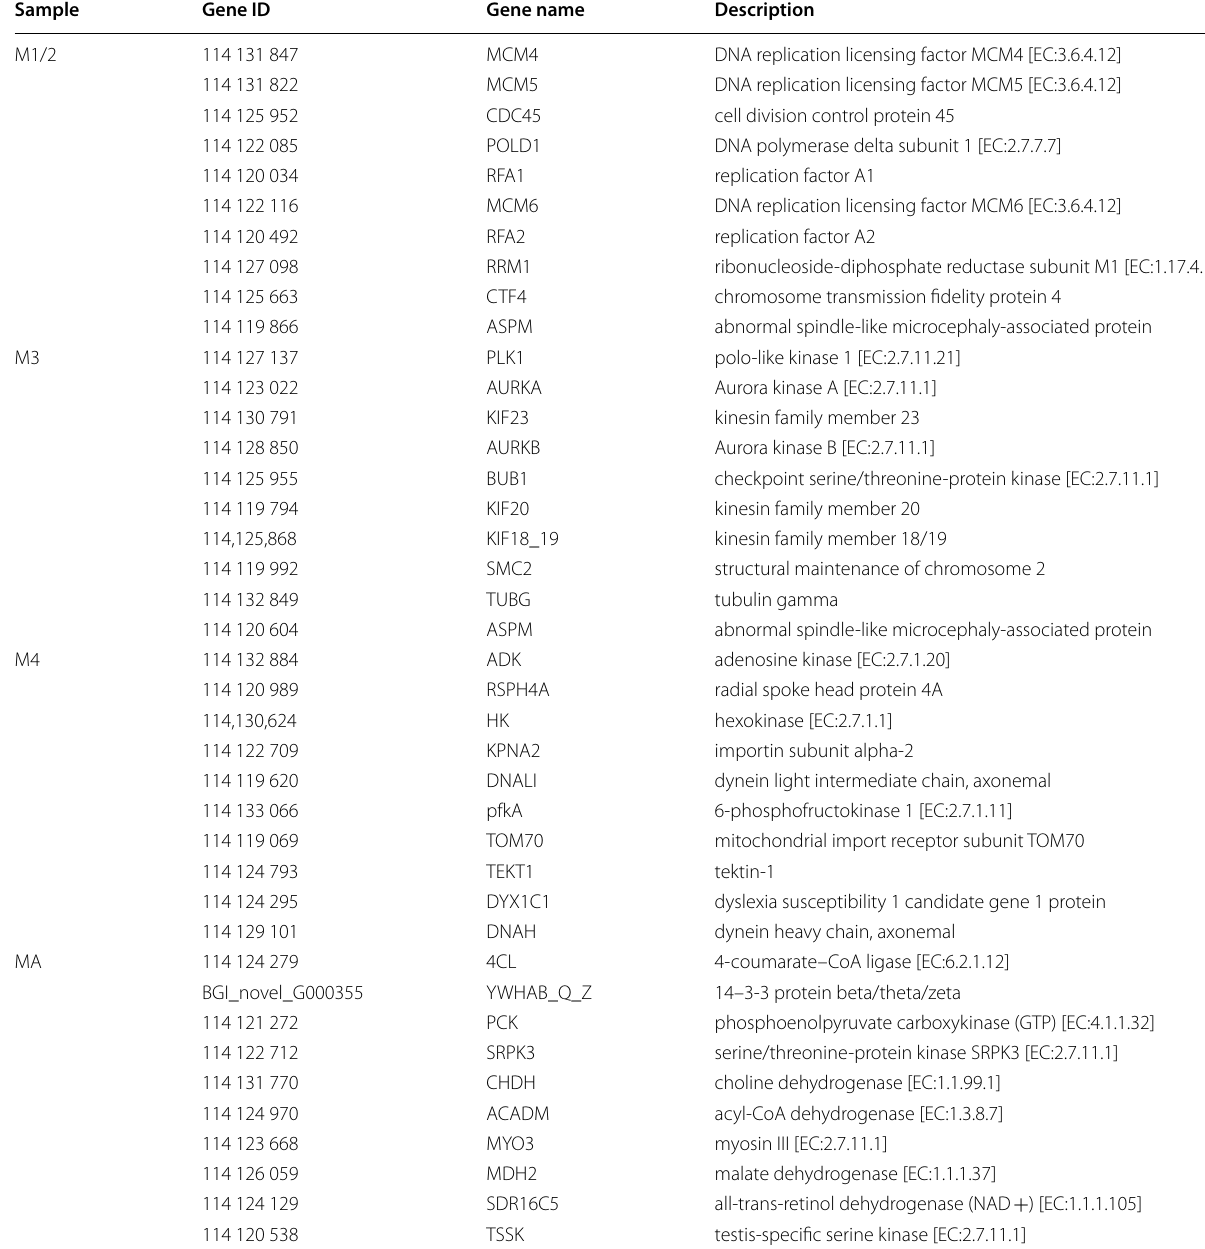
Table 2 The top 10 high interactive gene Sample Gene ID Gene name